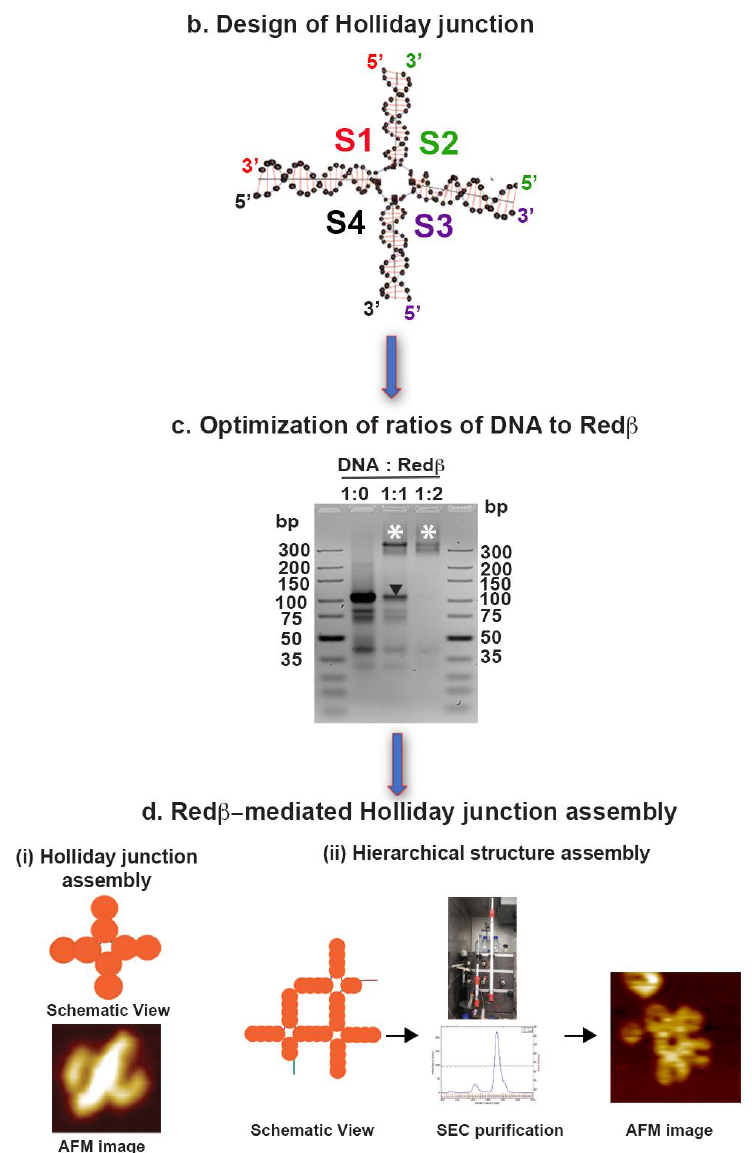
Figure 1. Experimental strategy for the Red β -mediated assembly of Holliday junction (HJ) structures. ( a ) Characteristic features of Red β . Models of the Red β quaternary structure are shown for the protein alone (20 × 20 nm 2 ), in complex with ssDNA, and in an annealed complex in the presence of two complementary ssDNA (20 × 20 nm 2 ). The models were adapted from [29]. ( b ) Design of HJ structures. Di ff erent HJ structures composed of four ssDNA strands (S1–S4) were designed using UNIQUEMER 3D [41] and employed as substrates in this study. ( c ) Optimization of DNA / Red β ratios by gel electrophoresis. The arrowhead pointing downwards indicates the free ssDNA, while the asterisks indicate the assembled HJ structures. ( d ) HJ assembly by Red β . ( i ) Schematic view and atomic force microscopy (AFM) image of a single HJ structure (50 × 50 nm 2 ). ( ii ) Schematic view, size exclusion chromatography (SEC) purification, and AFM image of a hierarchical HJ assembly (100 × 100 nm 2 ).